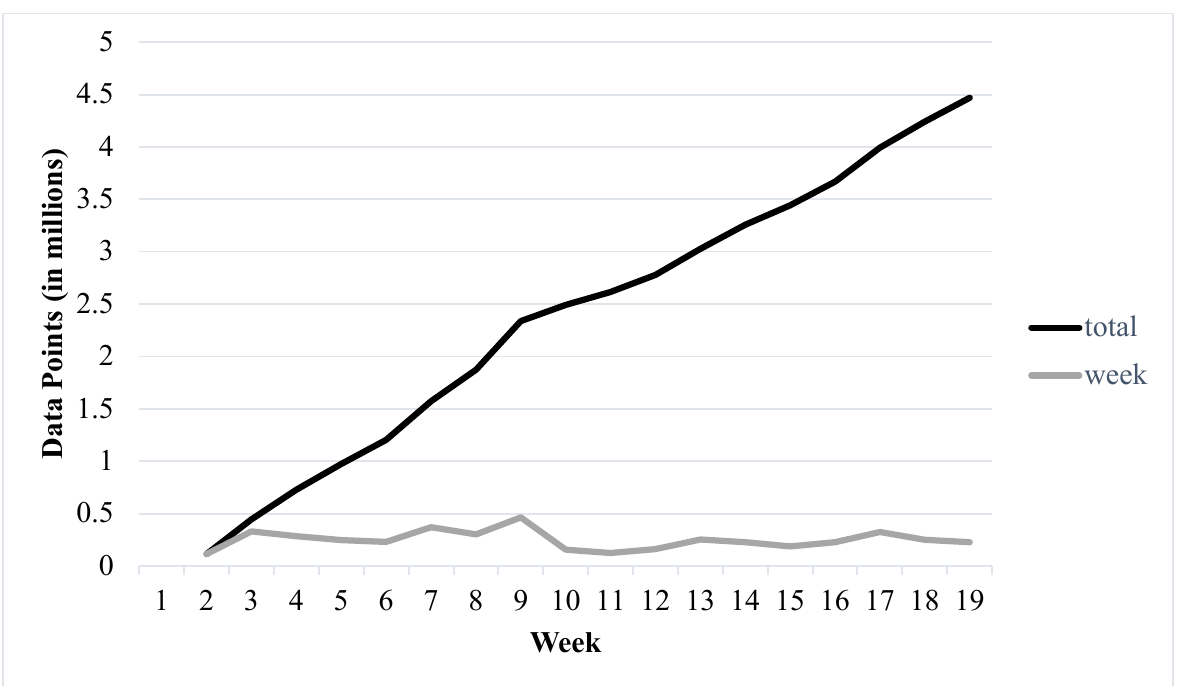
Figure 1 Cumulative Data Points and Weekly Distribution of the Four